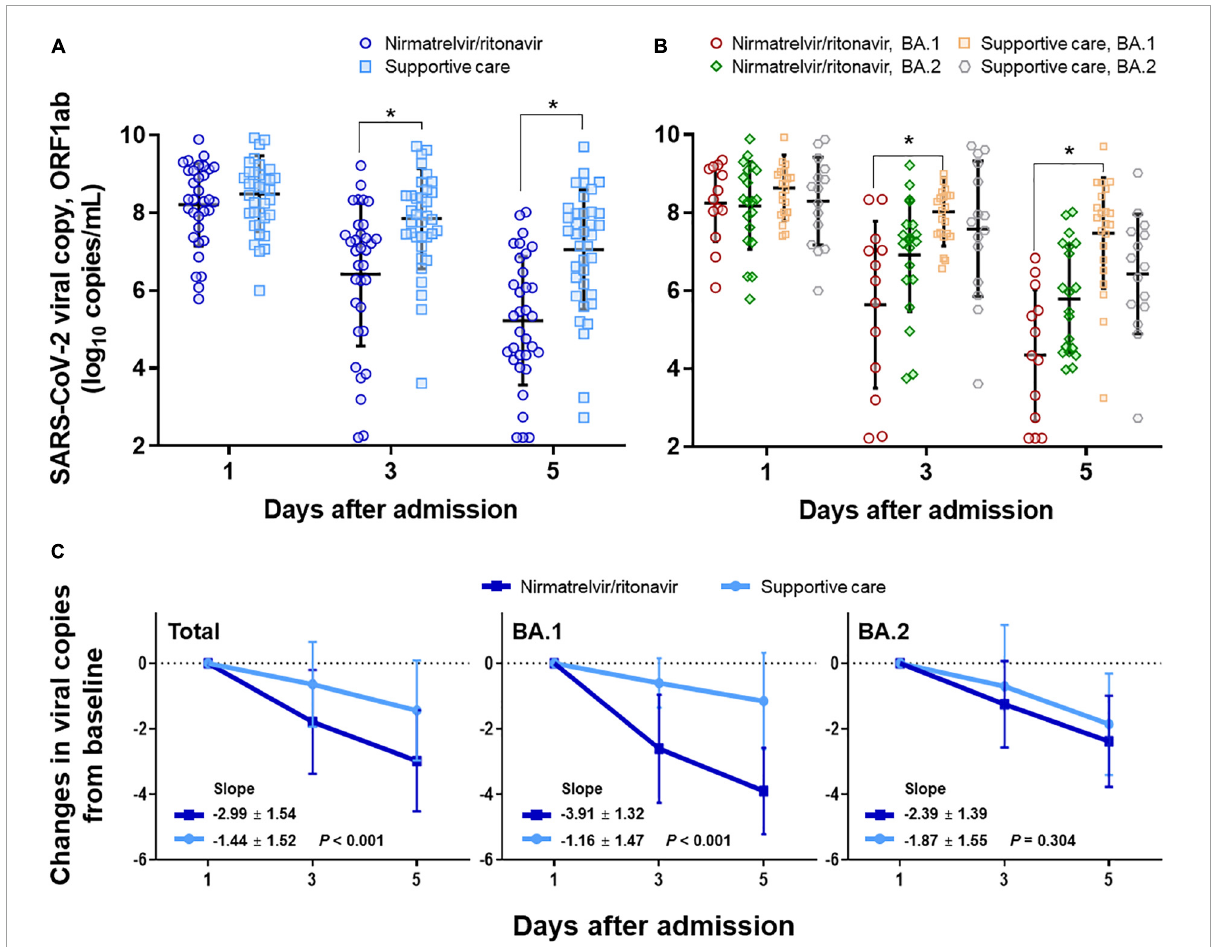
FIGURE2 Changes in viral load in response to nirmatrelvir/ritonavir treatment compared with supportive care. (A) Changes in viral load in response to nirmatrelvir/ritonavir or supportive care, total patients. (B) Subgroup analyses among patients with BA.1 variant infection and BA.2 variant infection, respectively. (C) Changes in viral copy numbers after adjusting for baseline viral loads. *Statistically